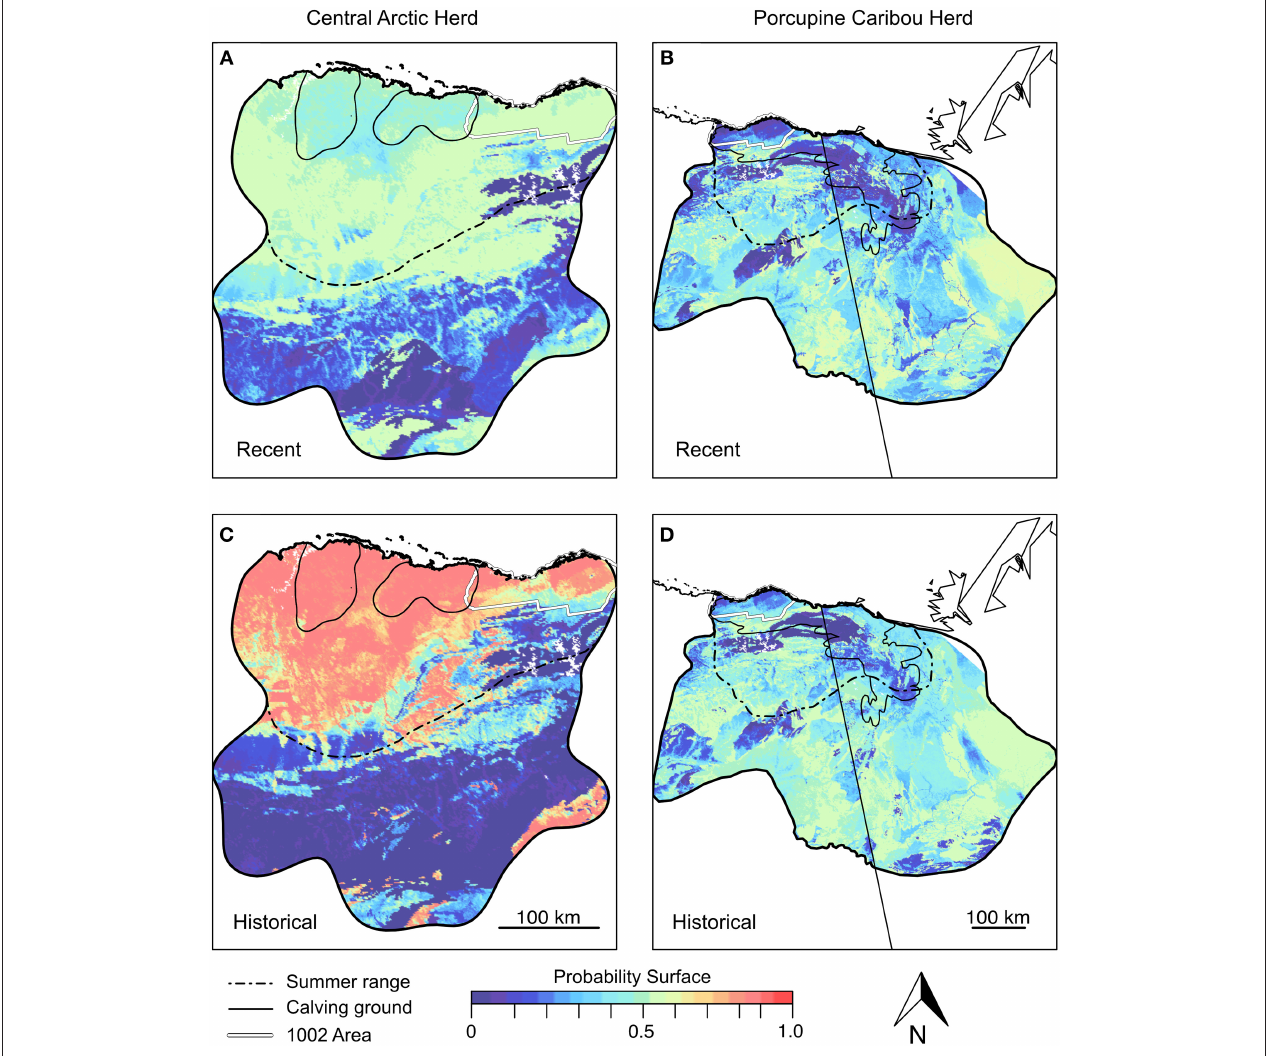
FIGURE 7 | Modeled Coastal Plain landscape use calculated from female antler 87 Sr/ 86 Sr. Recent (A,B) and historical (C,D) landscape use is estimated separately for the Central Arctic (A,C) and Porcupine Caribou Herds (B,D) . Historical landscape use for the Central Arctic Herd is estimated after removing the outlier. The Porcupine Herd is modeled by pooling female antlers from the Central and Eastern Coastal Plain. Sample sizes for calculations in panels (A–D) are n respectively. Outlines of modern summer ranges (dashed) and calving grounds (solid lines) are provided for reference within the annual range of each herd (black outline of probability surface). Herd range boundaries from Trammell et al.